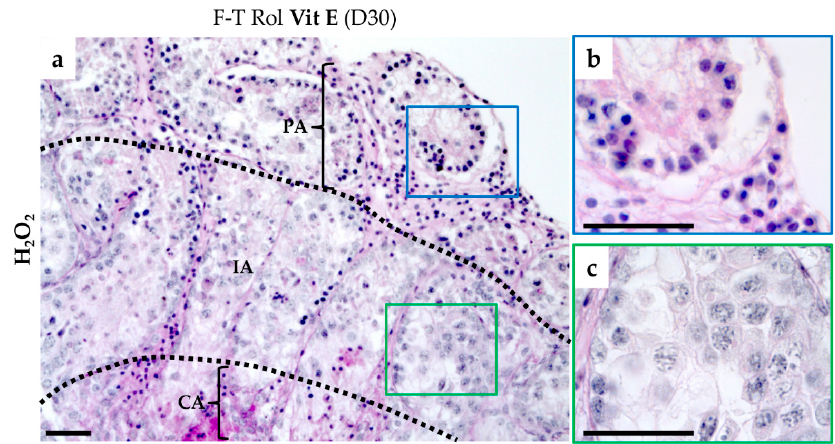
Figure 3. Histological view of the di ff erent regions of the cultured testis tissue pre-incubated with H 2 O 2 . ( a ) The peripheral area (PA) showed seminiferous tubules with totally pyknotic nuclei ( b ) due to direct contact with H 2 O 2 . The intermediate area (IA, black dotted lines) showed germ cell di ff erentiation ( c ) with less pyknotic nuclei due to low access of H 2 O 2 that could explain the low signal intensity for “cytoplasmic” (orange reagent) and “nuclear” (green reagent) ROS generation in this area of the cultured tissue. The central area (CA) showed no germ cell di ff erentiation with pyknotic nuclei due to low oxygen access and coincided with signal fluorescence for ROS detection. Photomicrographs were captured at a × 200 ( a ) or × 1000 ( b , c ) magnification. The scale bar represents 40 µ m in the photomicrographs. CA, central area; H 2 O 2 , hydrogen peroxide; IA, intermediate area; PA; peripheral area; ROS: reactive oxygen